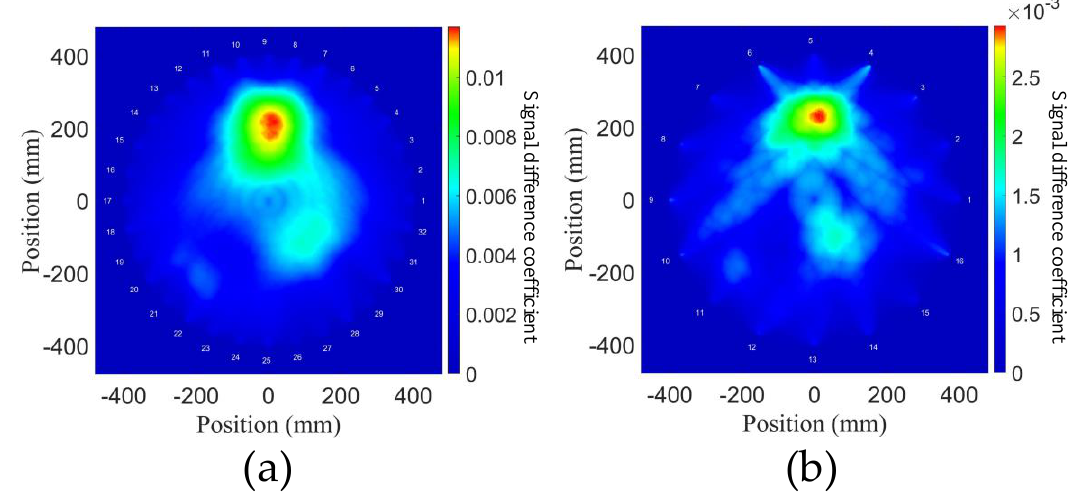
Figure 12. ( a ) Probability distributions for arrays composed of ( a ) 32 sensors and ( b ) 16 sensors, using the second harmonics for the NGW method.